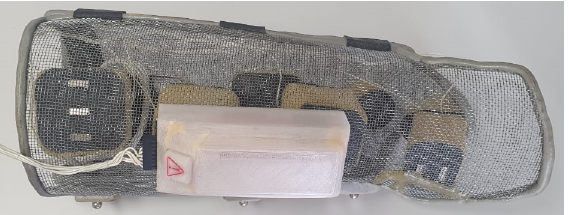
Figure 7. Mobile app screens.